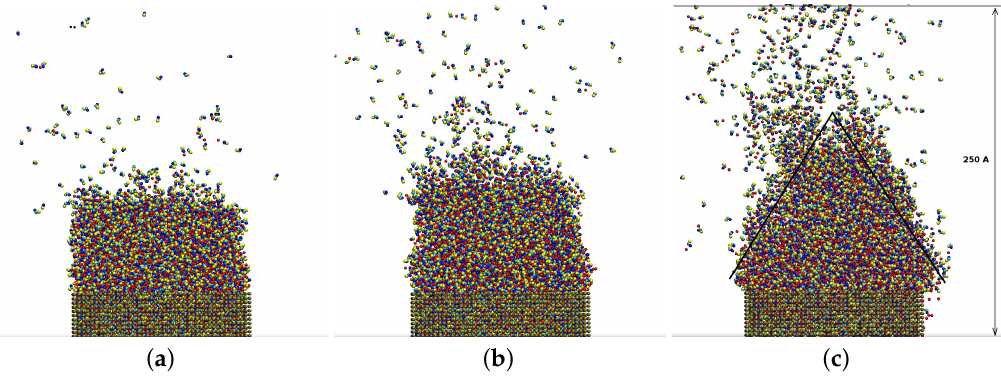
Figure 10. Snapshot of Taylor cone formation seen from coarse-grained MD simulation of EAN. Mass flow rate of 1.14 × 10 − 11 kg/s and extraction potential of − 60 V, respectively. Atom colors are: N1 (navy), E1 (teal), E2 (yellow), NN (red) and Pt (bronze). The capillary diameter is 112 Å, and the vertical dimensions are 250 Å. ( a ) At t = 200 ps; ( b ) At t = 300 ps; ( c ) At t = 400